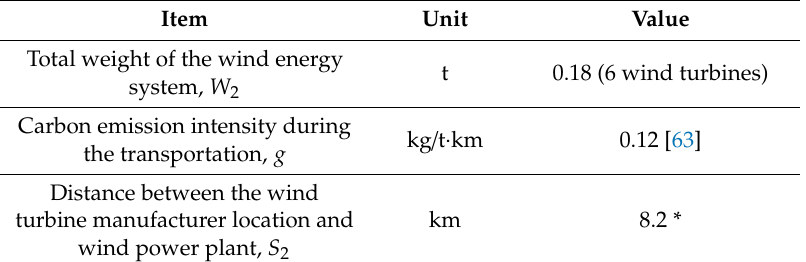
Table 9. Parameters for estimating the carbon dioxide emission in the wind turbines transportation. Item Unit Value Total weight of the wind energy t 0.18 (6 wind turbines) system, W 2 Carbon emission intensity during the transportation, g